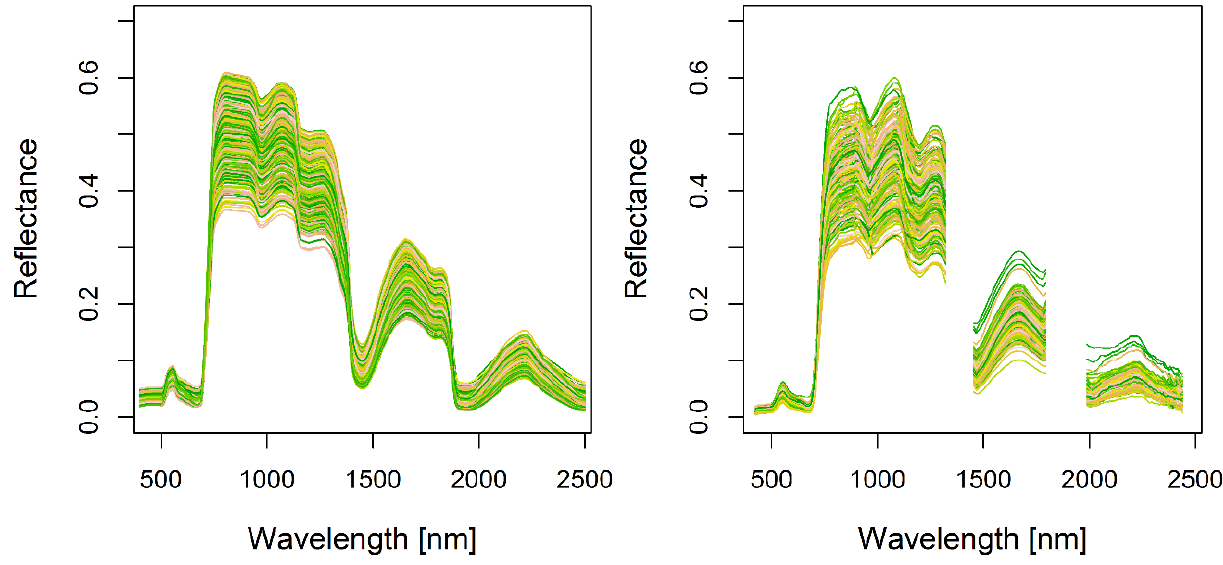
Figure 6. Modelled ( left ) compared to real ( right ) spectra of sunlit deciduous tree crowns.